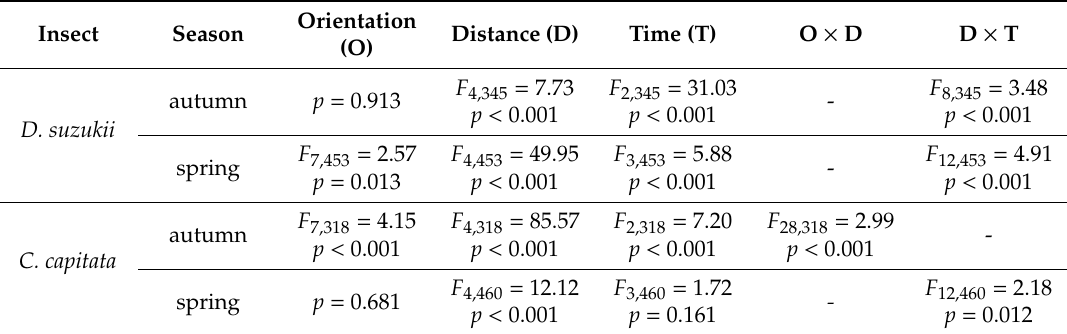
Table 2. Statistics of mark-release–recapture experiments *.